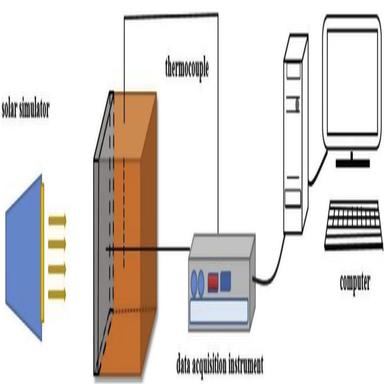
A diagram of the thermal performance evaluation system under solar irradiation.